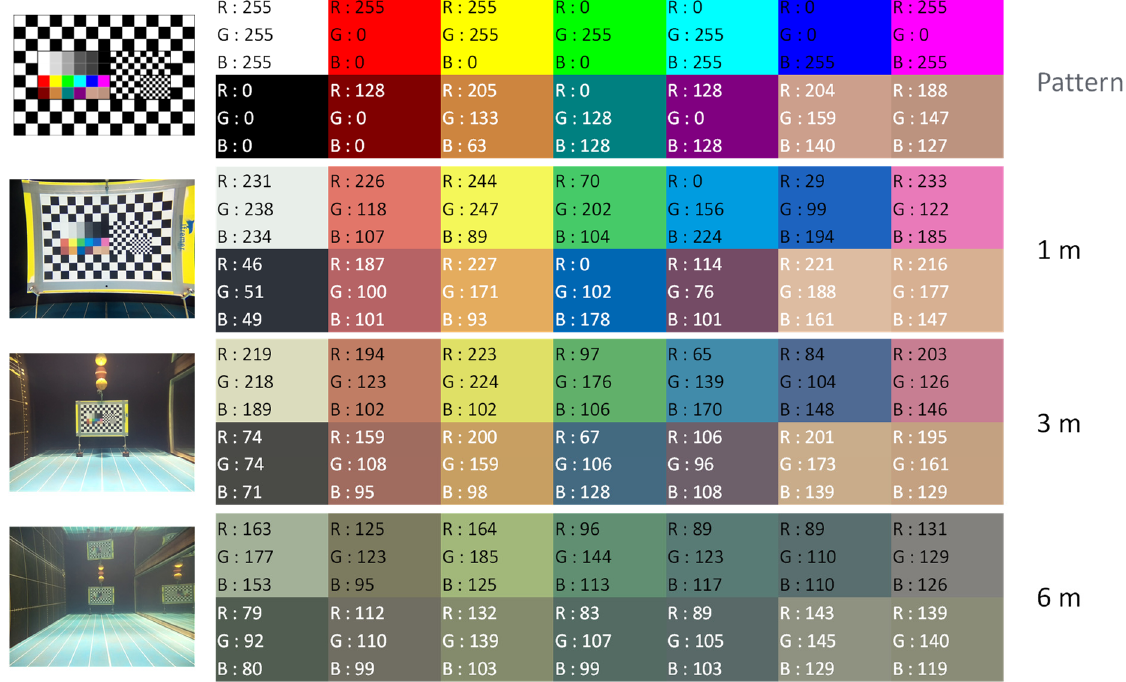
Figure 11. KOSMOS RGB coefficients at distances of 1, 3, and 6 m. Top: RGB coefficients for test pattern.